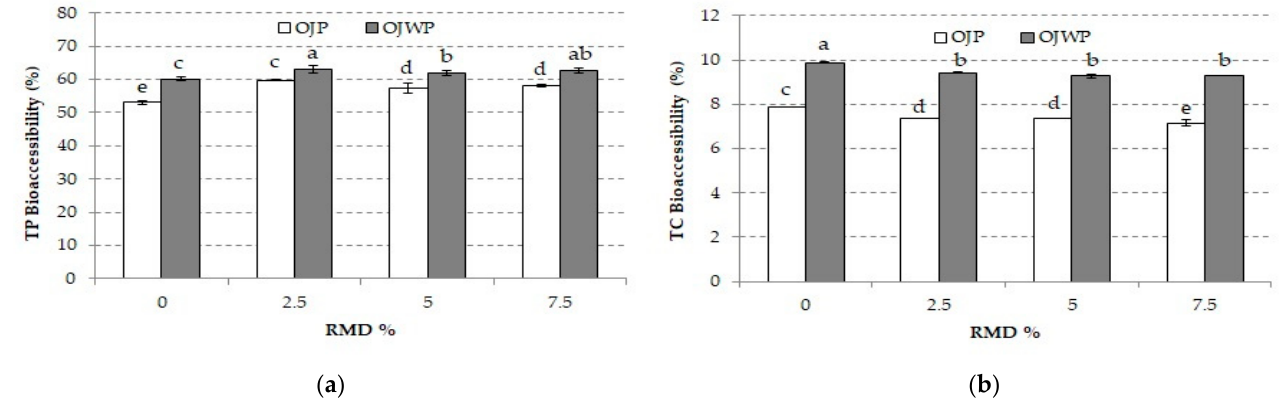
Figure 5. ( a ) Mean values and standard deviation of total phenols (TP) bioaccessibility of pasteurized orange juice (OJP and OJWP) with 0, 2.5, 5, and 7.5 RMD%. ( b ) Mean values and standard deviation of total carotenoids (TC) bioaccessibility of pasteurized orange juice (OJP and OJWP) with 0, 2.5, 5, and 7.5 RMD%. Letters indicate homogeneous groups established by the ANOVA ( p < 0.05) for each parameter analyzed. OJP, orange juice with pulp; OJWP, orange juice without pulp.